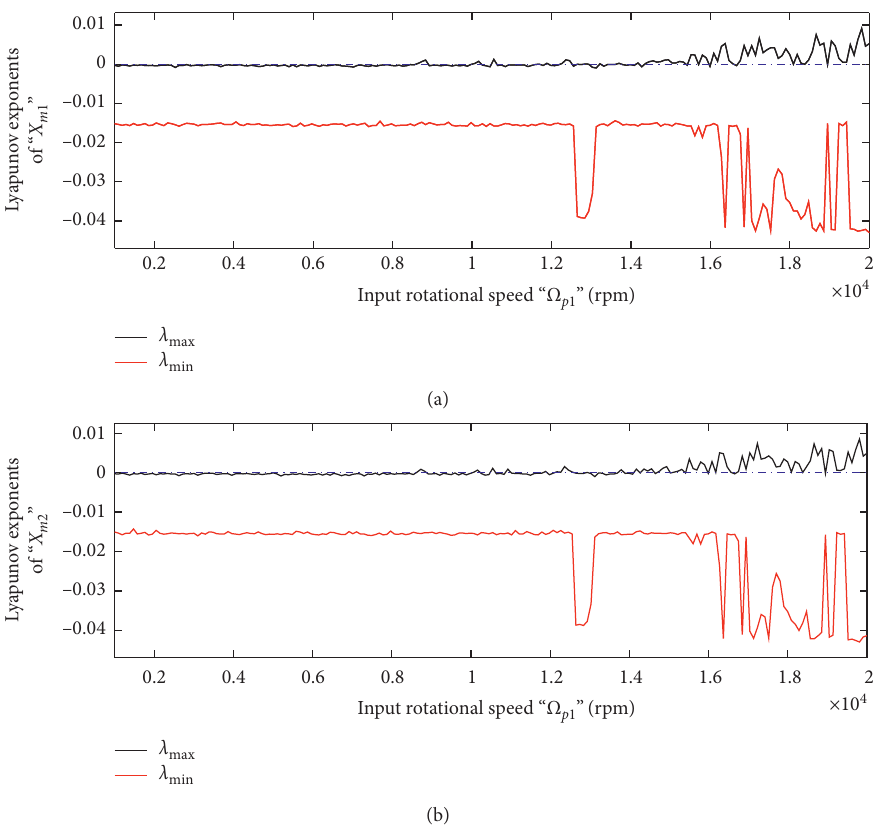
Figure 25: Lyapunov exponents of the system under the motor torque fluctuation of T